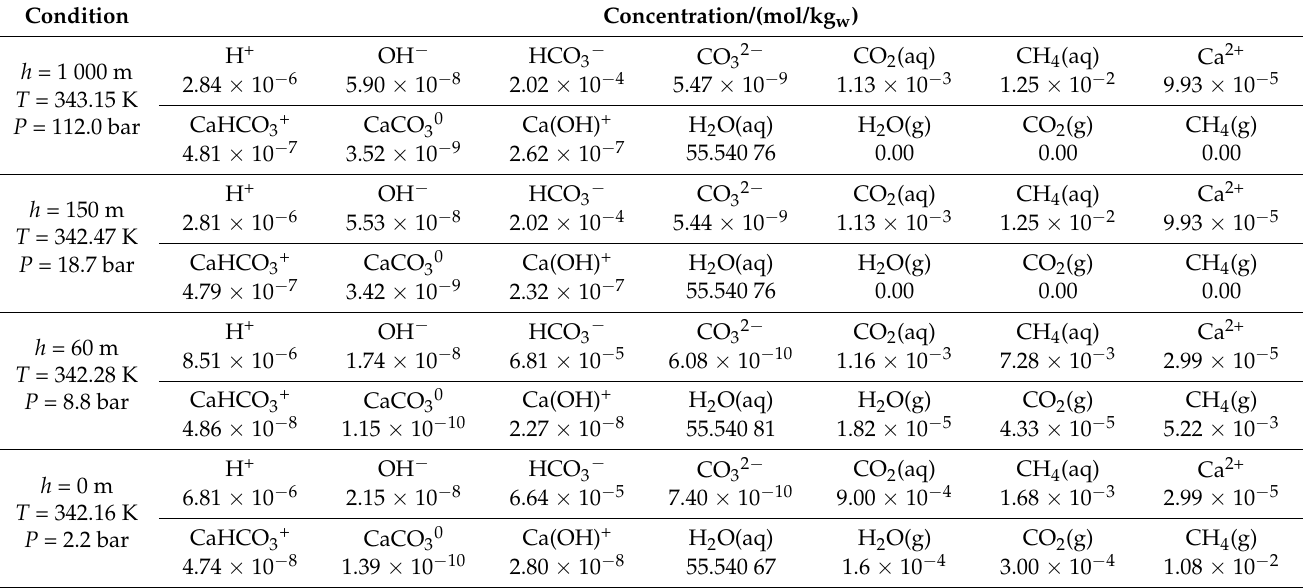
Table 4. Concentration of each component in the geothermal water at different depths of the